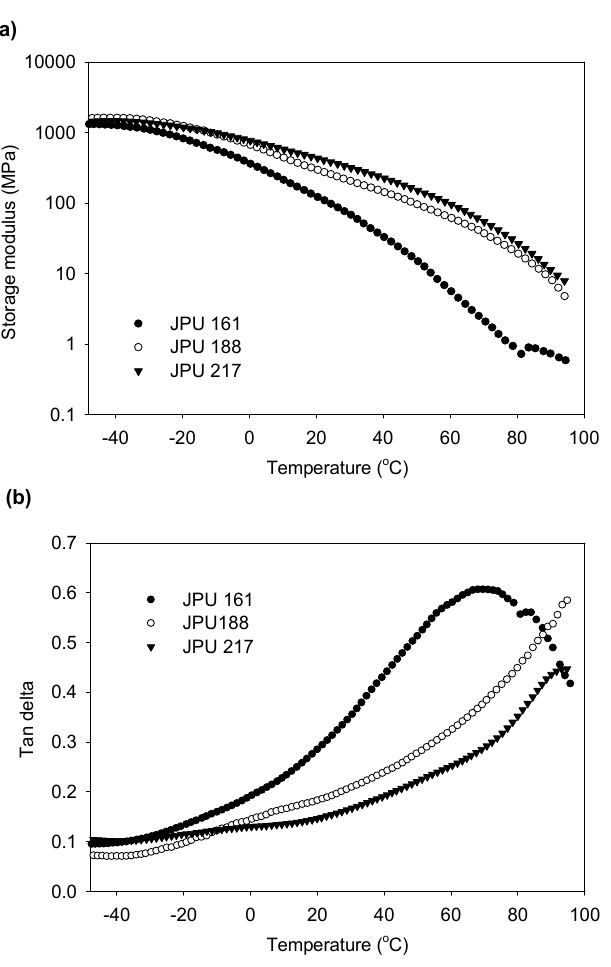
Figure 9. Storage modulus ( a ) and, tan delta ( b ), as a function of temperature for JPU films produced from various OH number